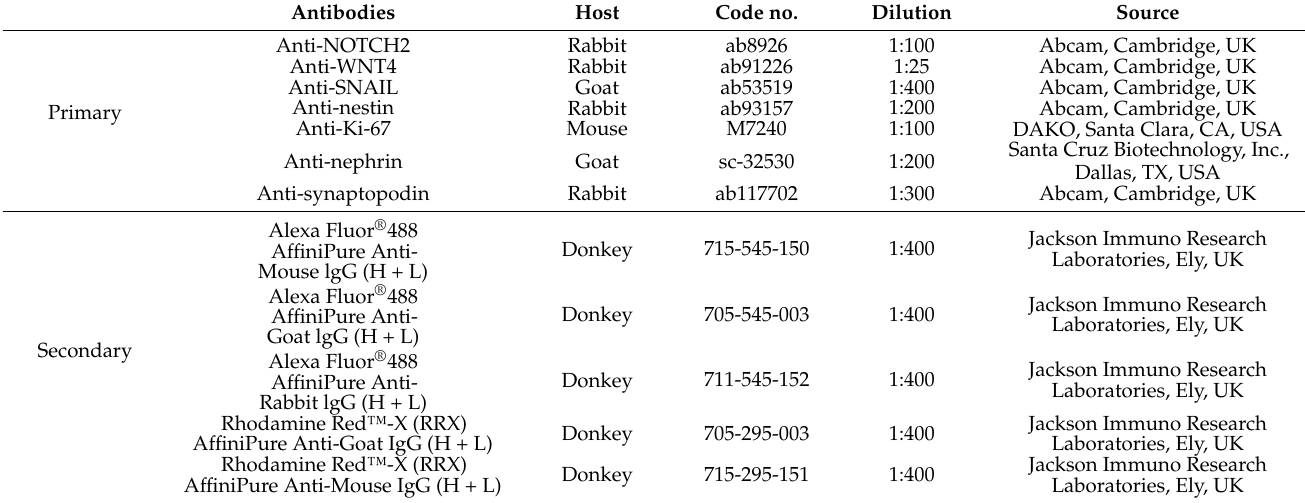
Table 3. Primary and secondary antibodies used in the